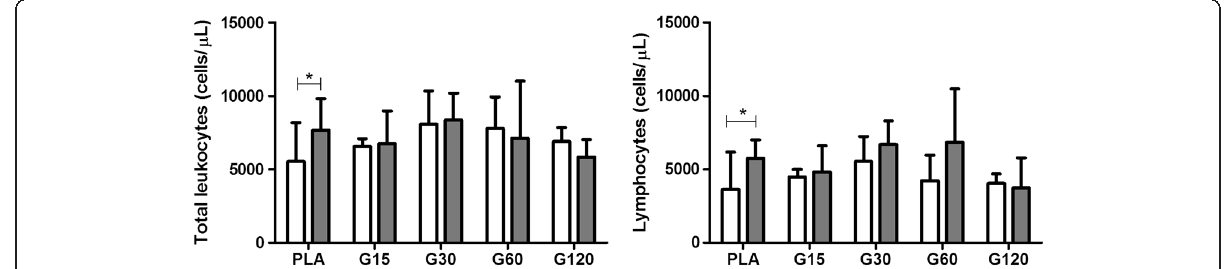
Figure 3 Effects of different doses of MVIIC on total leukocytes (cells/ μ L) and lymphocytes (cells/ μ L). Mean number ± SD of total leukocytes and lymphocytes of rats submitted to compressive spinal cord injury and treated with placebo (PLA, positive control) or ω -conotoxin MVIIC (G15, 15 pmol MVIIC; G30, 30 pmol MVIIC; G60, 60 pmol MVIIC), preoperatively (white column) and eight days after treatment (gray column) (* p < 0.05). Total leukocyte and lymphocyte normal values are, respectively, 1980 – 11060 cells/ μ L and 1190 – 9450 cells/ μ L, as described by Giknis and Clifford